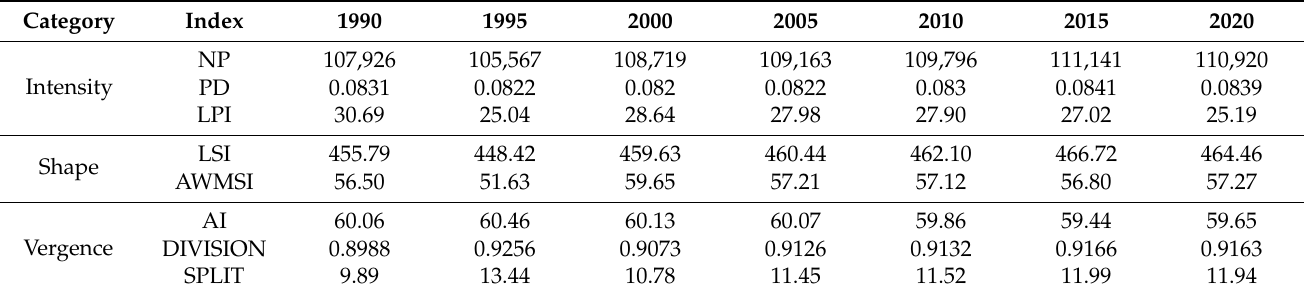
Table 4. Results of the landscape pattern analysis of